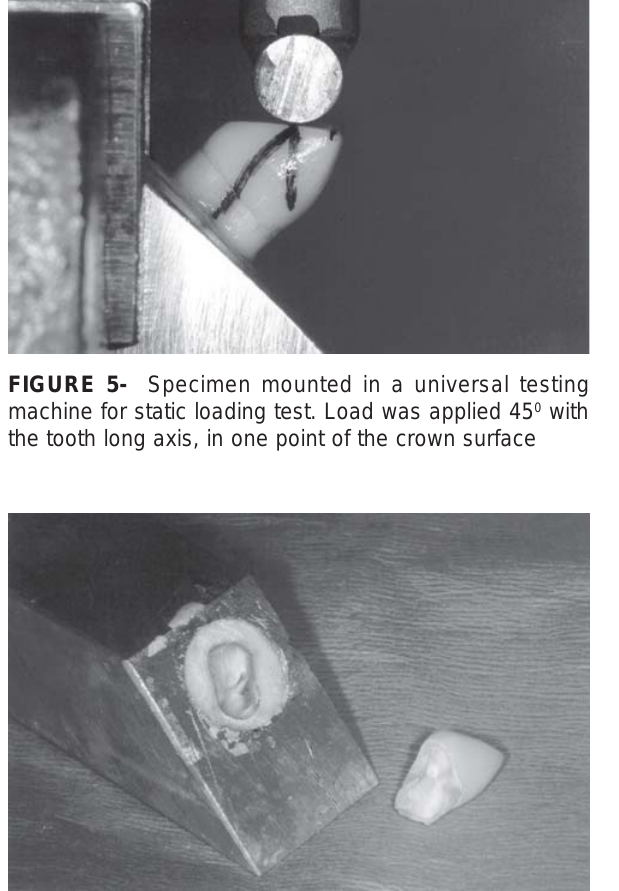
FIGURE 6- Catastrophic fracture mode in the ZI group. The line of fracture is located more than 1mm below the acrylic